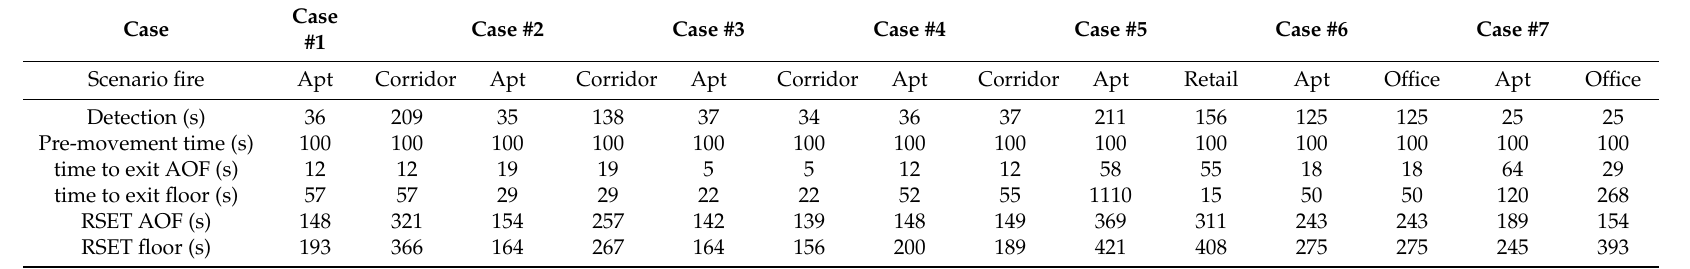
Table 8. RSET analysis [di ff erent cases] based on Trial Design #1.